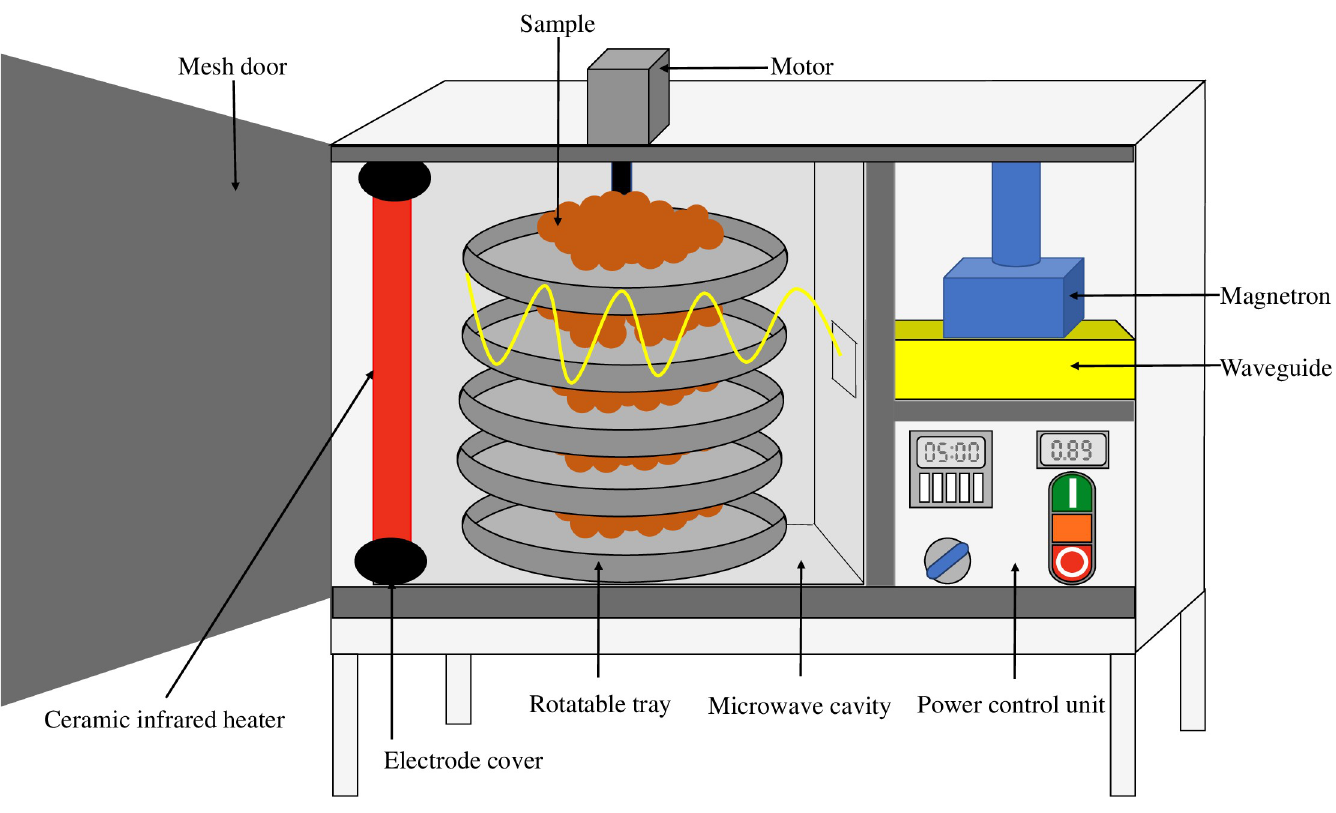
Fig 1. Hybrid microwave-infrared